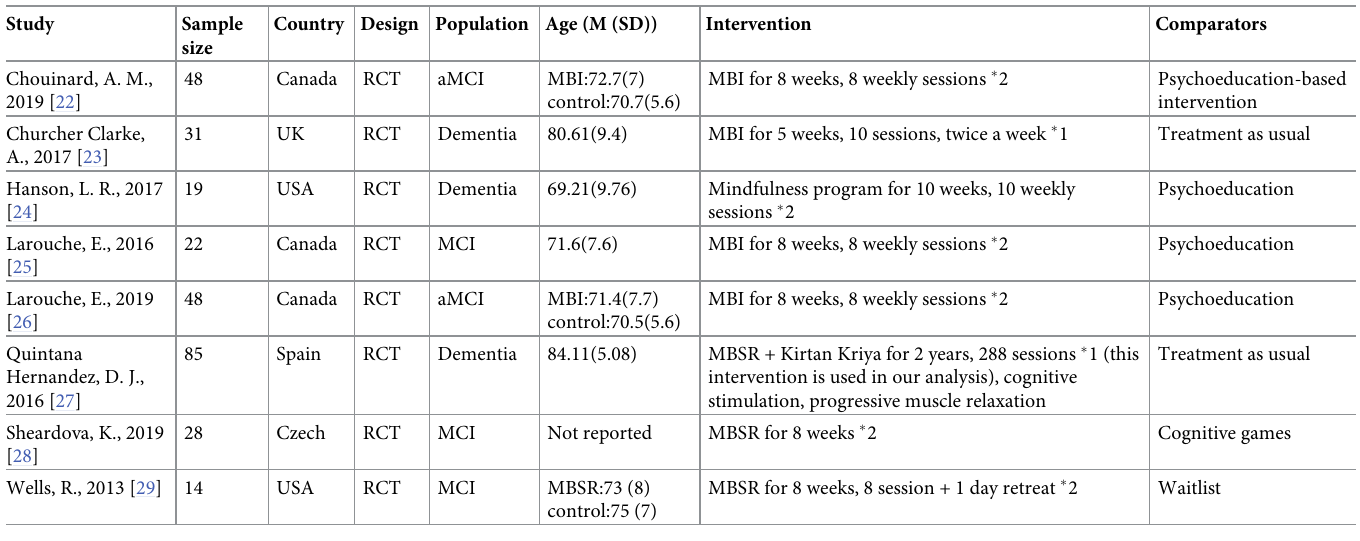
Table 1. Characteristics of included studies.